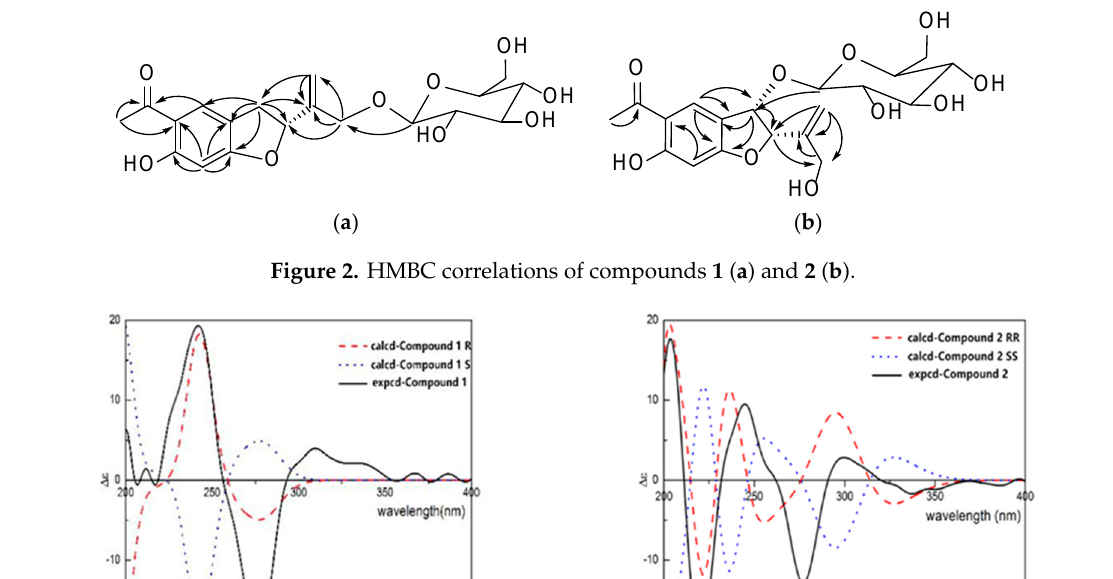
Figure 1. Structure of the isolated compounds from T. patula .